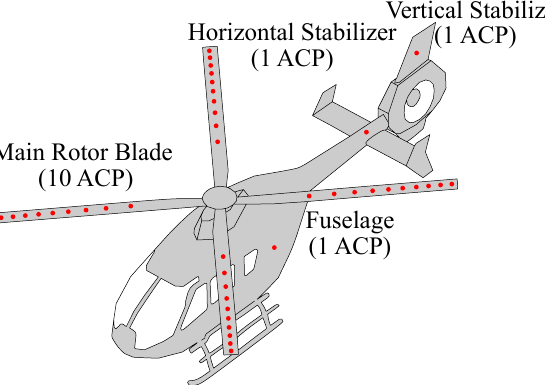
Figure 13. Distribution of airload computation points (ACPs) in HeliWorX.